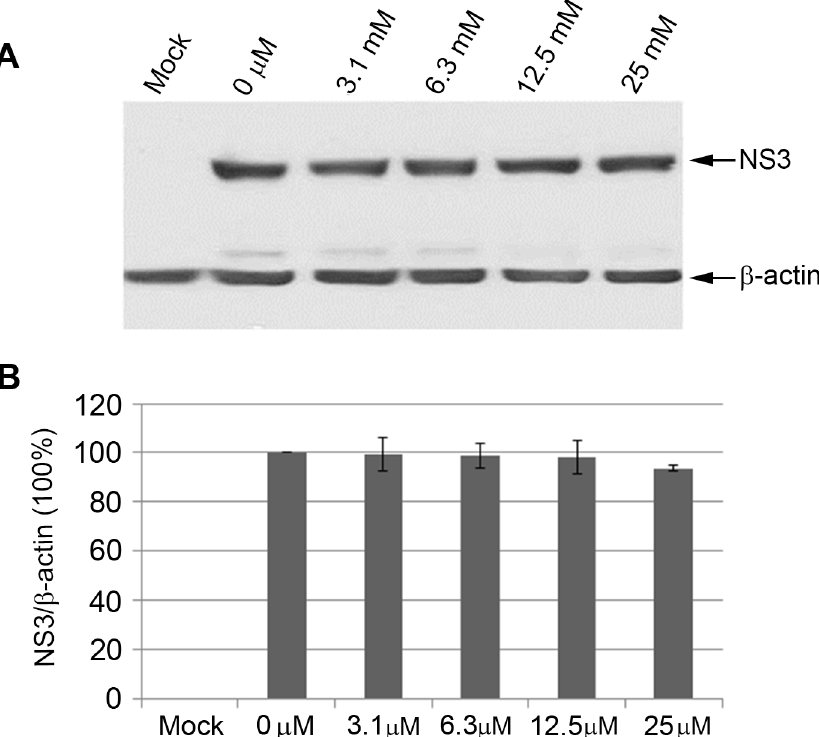
Fig 4. Tannic acid does not inhibit HCV replication. (A) The effect of tannic acid on a HCV replicon, that displays intracellular replication events, was determined. HCV1b replicon RNA was electroporated into Huh7.5 cells followed by seeding of cells into six-well plates. After 48 hours of culture cells were trypsinized and seeded into twelve-well plates and tannic acid was added at concentrations of 0 μ M, 3.1 μ M, 6.3 μ M, 12.5 μ M and 25 μ M and cells were cultured for 48 hours as described in Materials and Methods. Mock electroporation (no HCV1b replicon RNA) of cells provided controls. Cells were lysed and Western blots were done with anti-NS3 monoclonal antibodies as described in Materials and Methods. Experiments were performed three times and representative examples are shown. (B) The levels of NS3 were normalized to β - actin and the ratios of NS3/ β -actin relative to 0 μ M tannic acid (no inhibitor, 100% level of NS3) were plotted against inhibitor concentrations. The data are presented as mean ± SD (n = 3) of the NS3 levels normalized to β -actin for three independent